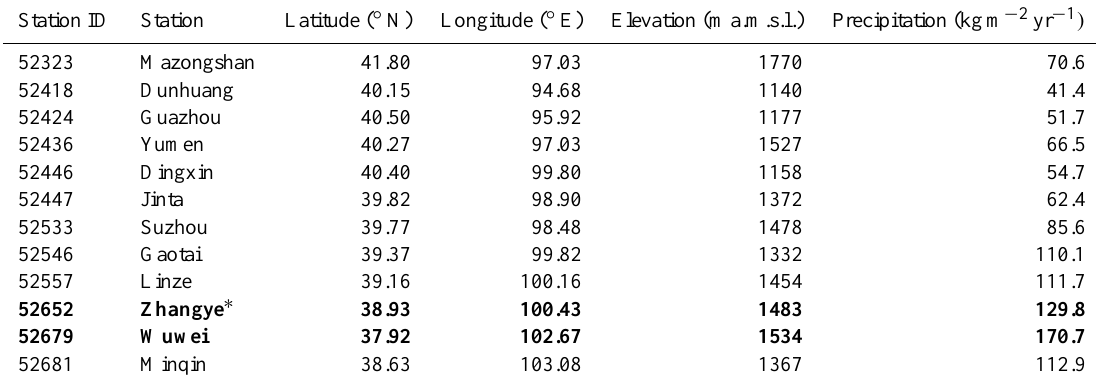
Table 1. List of weather stations, their coordinates, elevation, and mean total annual precipitation based on measurements from 1976 to 2005. Stations are located within or near the Hexi Corridor (Fig.